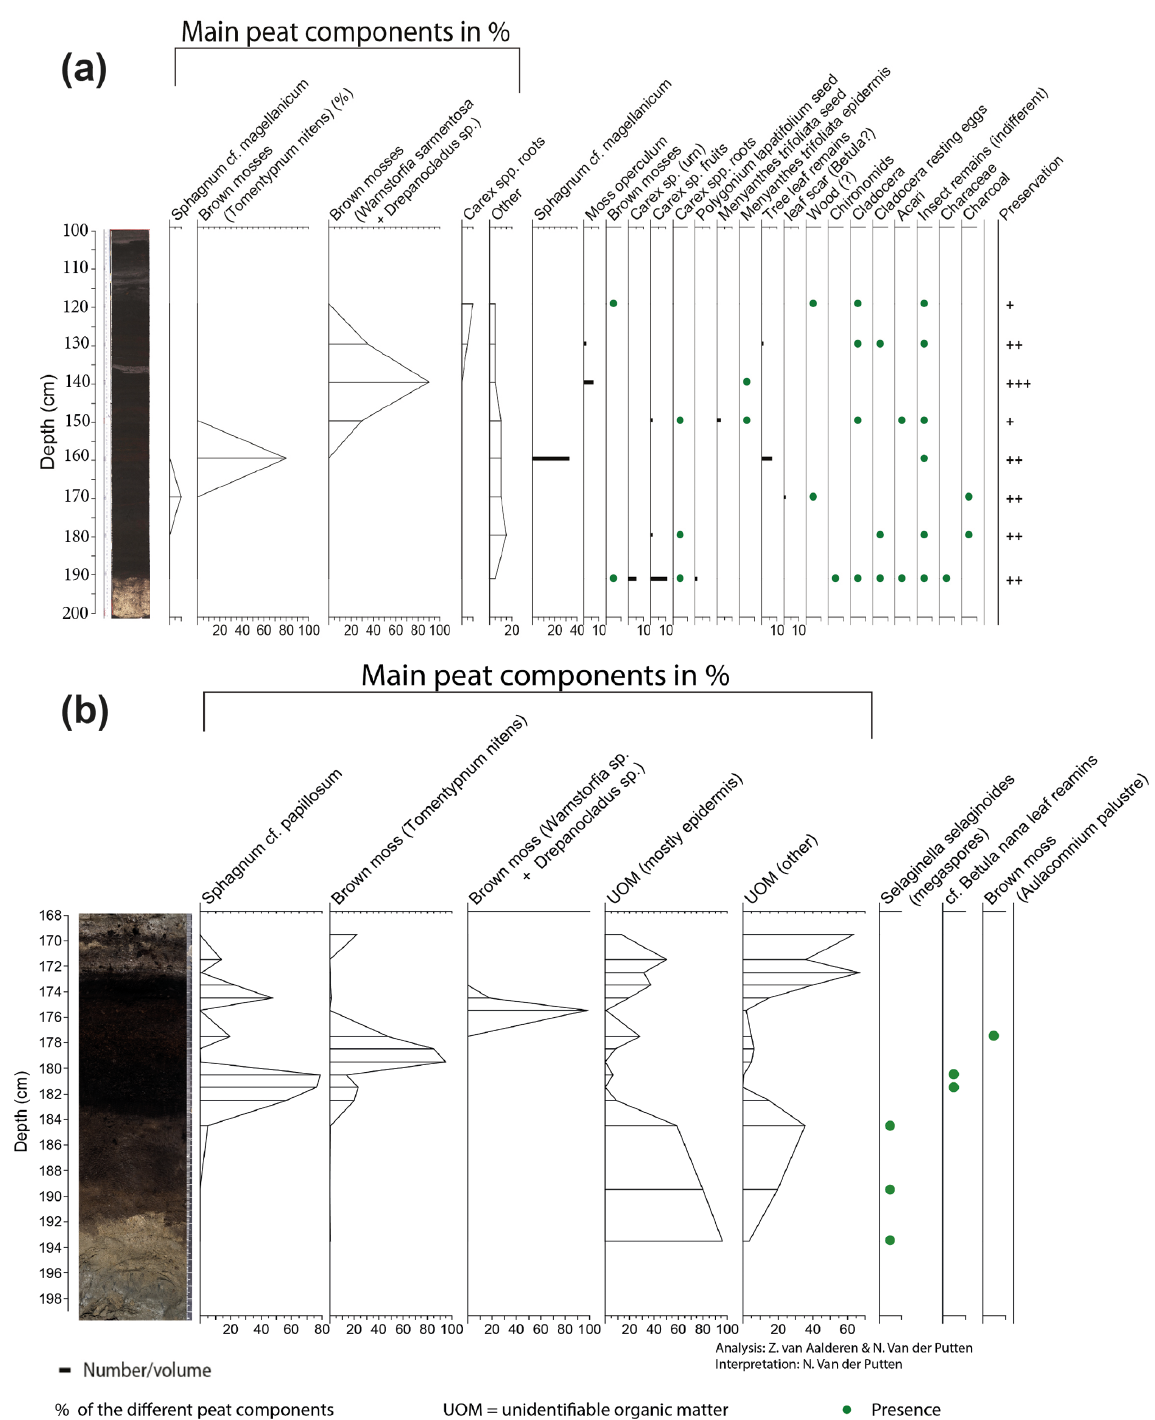
Figure 4. Macrofossil diagrams of the (a) Max Gundelach site. Preservation of the plant remains are qualitatively estimated and expressed using a three-step scale: + (good), ++ (very good), and +++ (excellent). (b) The Fredricksborg NE site against depth and core photograph. The main peat components of both sites are quantified using the quadrat and leaf count (QLC) method (see methods). They are expressed as percentages (%) and are shown as hollow curves, with the lines indicating the depth of the samples. The complete sample was screened for additional less abundant taxa which are expressed as concentrations (number of remains per unit of volume) and shown as black bars. Rare taxa are shown as being present with green